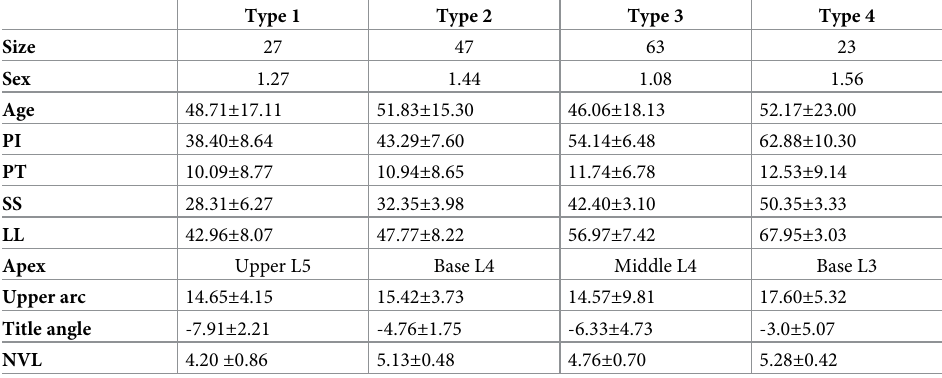
Table 2. Spino-pelvic parameters of Roussouly’s sagittal spino-pelvic morphotypes from a group of 160